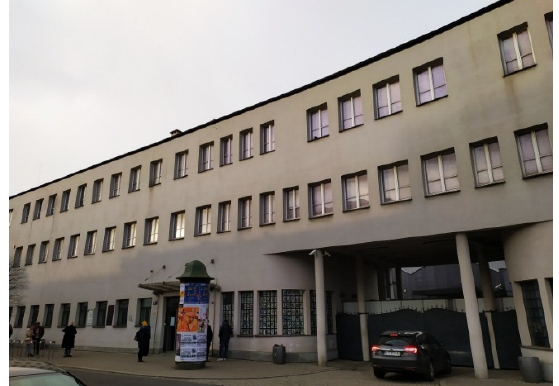
Figure 12. Museum-Oskar Schindler’s Enamel Factory in Cracow (Item 10, Figure 1) (photo by E. Latusek).